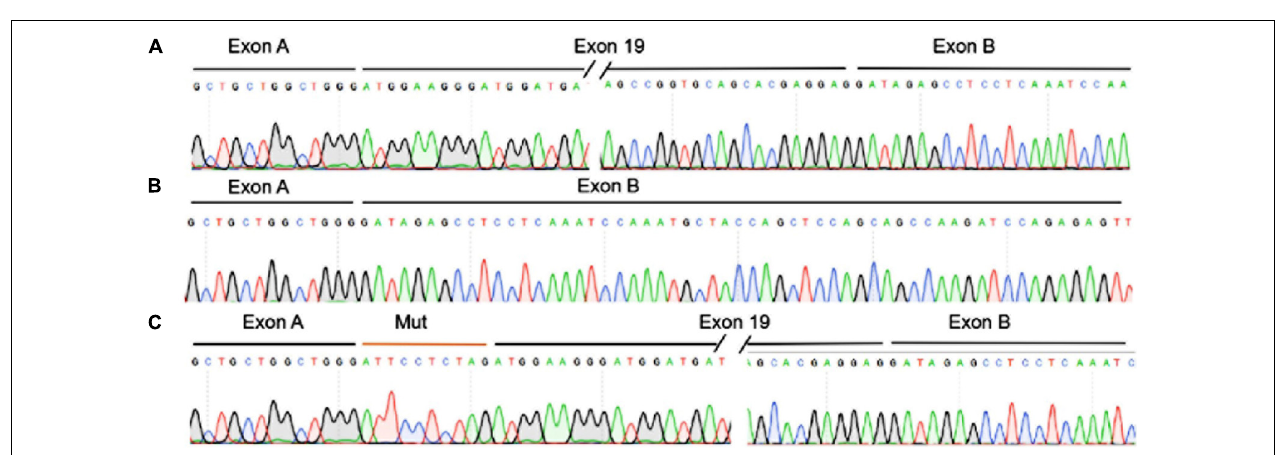
FIGURE 1 | The TJP2 c.1202A > G (p.Glu401Gly) is a novel pathogenic variant. (A) The mutant HepG2 cells show a significantly higher TJP2 mRNA expression level than the wild-type HepG2 cells. (B) The mutant HepG2 cells show a significantly higher TPJ2 protein expression level than the wild-type HepG2 cells. (C) The cell viability was significantly enhanced in mutant HepG2 cells at 48 h as compared to wild-type HepG2 cells. (D) TJP2 protein was enriched in the nucleus of TJP2 c.1202A > G mutated HepG2 cells. DAPI indicates that the nuclei are stained with 4’,6-diamidino-2-phenylindole, dihydrochloride (DAPI). Merge represents the merged fluorescent image of nucleus and cytoplasm labeled by red and blue fluorescence.